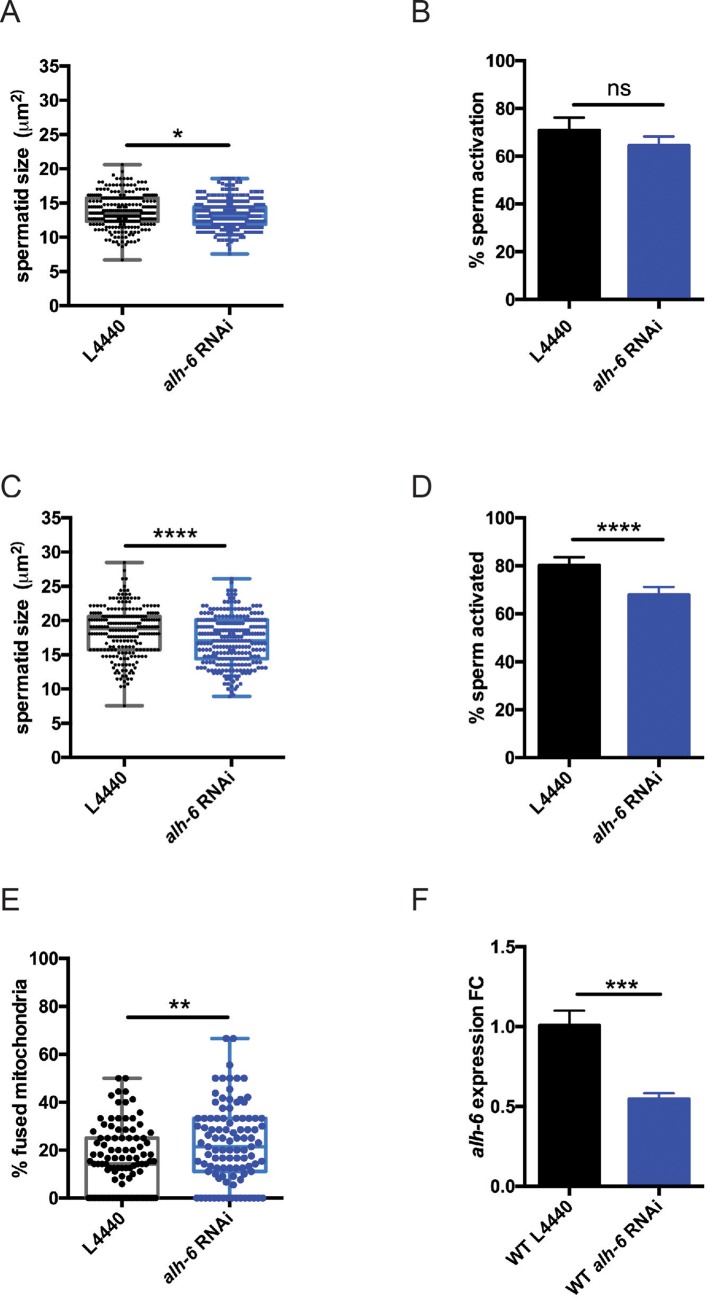
Germline expression of WT alh-6 is sufficient to rescue sperm defect.(A–B) Soma-restricted RNAi of alh-6 slightly reduces sperm size (A), but does not affect sperm activation (B). (C–F) Whole animal RNAi of alh-6 reduces sperm size (C), impairs activation (D), and increases mitofusion in spermatids (E). (F) alh-6 expression is reduced by whole animal RNAi as shown in RT-PCR verification. Statistical comparisons done by unpaired t-test for all experiments except for sperm activation, which is done by Fischer’s exact test. All studies performed in biological triplicate; refer to Supplementary file 1 for n for each comparison.